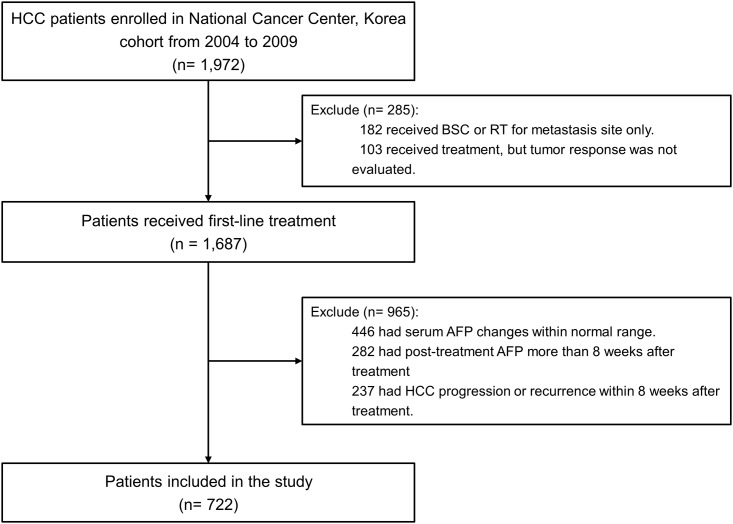
Study flows.Abbreviations: AFP, alpha-fetoprotein; BSC, best supportive care; HCC, hepatocellular carcinoma; RT, radiotherapy.